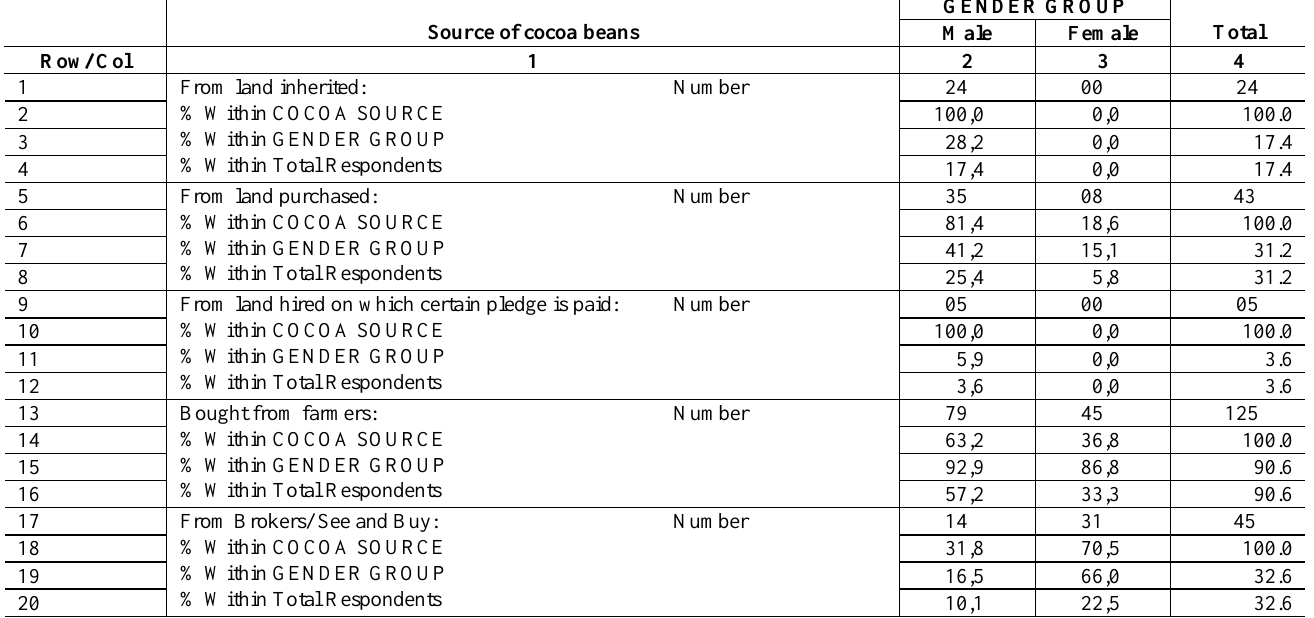
Table 9: Sources of marketed cocoa beans by marketers and by gender; Idanre, Ondo State of Nigeria. 2000/2001